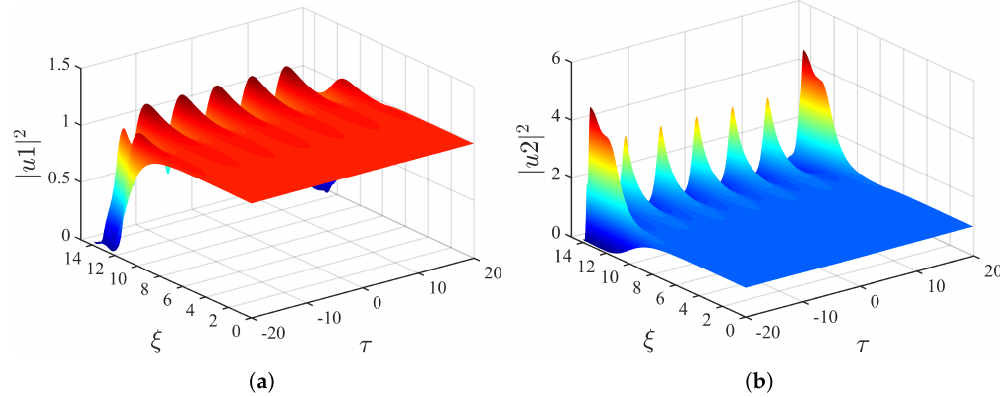
Figure 17. The MI evolution in the bar ( a ) and cross ( b ) cores, in the case of the anomalous GVD in the bar channel, and zero GVD ( α = 0) in the cross channel. Other parameters are A 1 = A 2 = ω 0 = Γ = κ = 1 and a 0 = 0.0001.